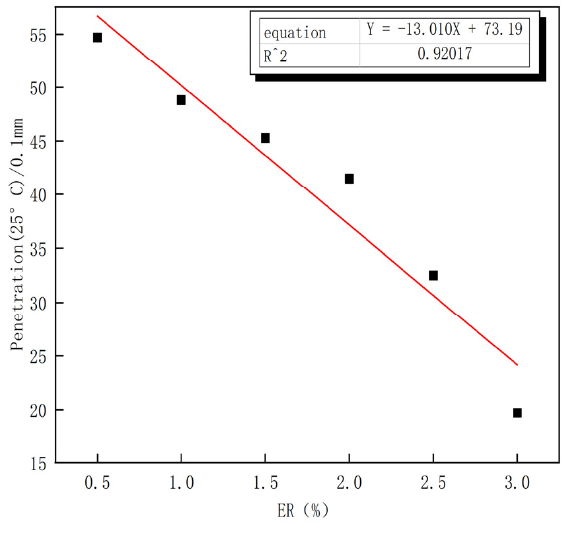
Figure 2. Relationship between ER content and penetration degree.